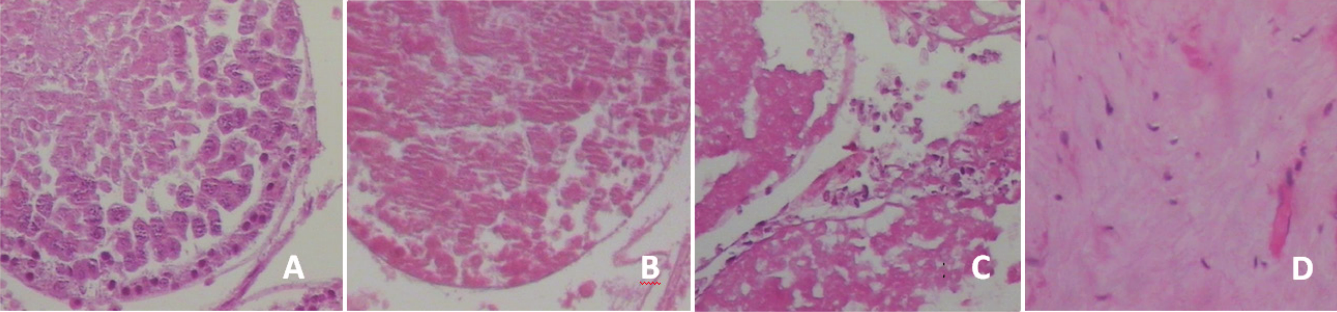
FIGURE 3 - Figures A, B, C and D show the histological findings of the twisted left testes collected at one, five, ten and 90 days, respectively (HE, 200X): A ) Preserved cells in the periphery of the seminiferous tubules and their lumens with necrotic anucleated and exfoliated cells; B ) Completely necrotic, exfoliated and anucleated cells, tubules still with the normal shape; C ) Totally necrotic seminiferous tubules and activity of the leukocytes (phagocytosis); D ) Testes completely replaced by collagen, with the presence of capillaries and fibroblasts. TABLE 1 - Results of the parameters of the right contralateral testes spermatogenesis of the experimental and control subgroups. STD (µ) b Johnsen score c NPSP/ST e RTW (g) a NRS/ST d Subgroups n (x̄ ± s) (x̄ ± s) (x̄ ± s) (x̄ ± s) (x̄ ± s) ESG.01 10 1.83 ± 0.12 283.05± 7.90 9.94 ± 0.10 70.59 ± 1.60 22.21 ± 0.90 ESG.05 10 1.80 ± 0.16 280.48 ± 5.14 9.91 ± 0.10 69.30 ± 2.28 22.53 ± 0.55 ESG.10 10 1.78 ± 0.10 277.88 ± 8.26 9.89 ± 0.14 70.83 ± 1.64 22.07 ± 0.84 ESG.90 10 1.79 ± 0.07 279.59 ± 4.53 9.93 ± 0.09 71.10 ± 1.94 22.39 ± 0.58 CSG.SO 24 1.84 ± 0.04 280.06 ± 3.36 9.93 ± 0.10 70.68 ± 1.45 22.45 ± 0.62 CSG.LO 10 1.82 ± 0.11 282.15 ± 5.19 9.92 ± 0.11 69.94 ± 1.88 22.43 ± 0.58 RTW = right testis weight; STD = seminiferous tubule diameter; NRS/ST = number of round spermatids per cross-section of the seminiferous tubule; NPSP/ST = number of primary spermatocytes in pachytene per cross-section of the seminiferous tubule; x̄ ± s = mean ± standard deviation. a,b,c,d,e No statistically significant differences were observed among the experimental and control subgroups for all of the parameters (Mann-Whitney test, -1.96 ≤ z ≤ 1.96,